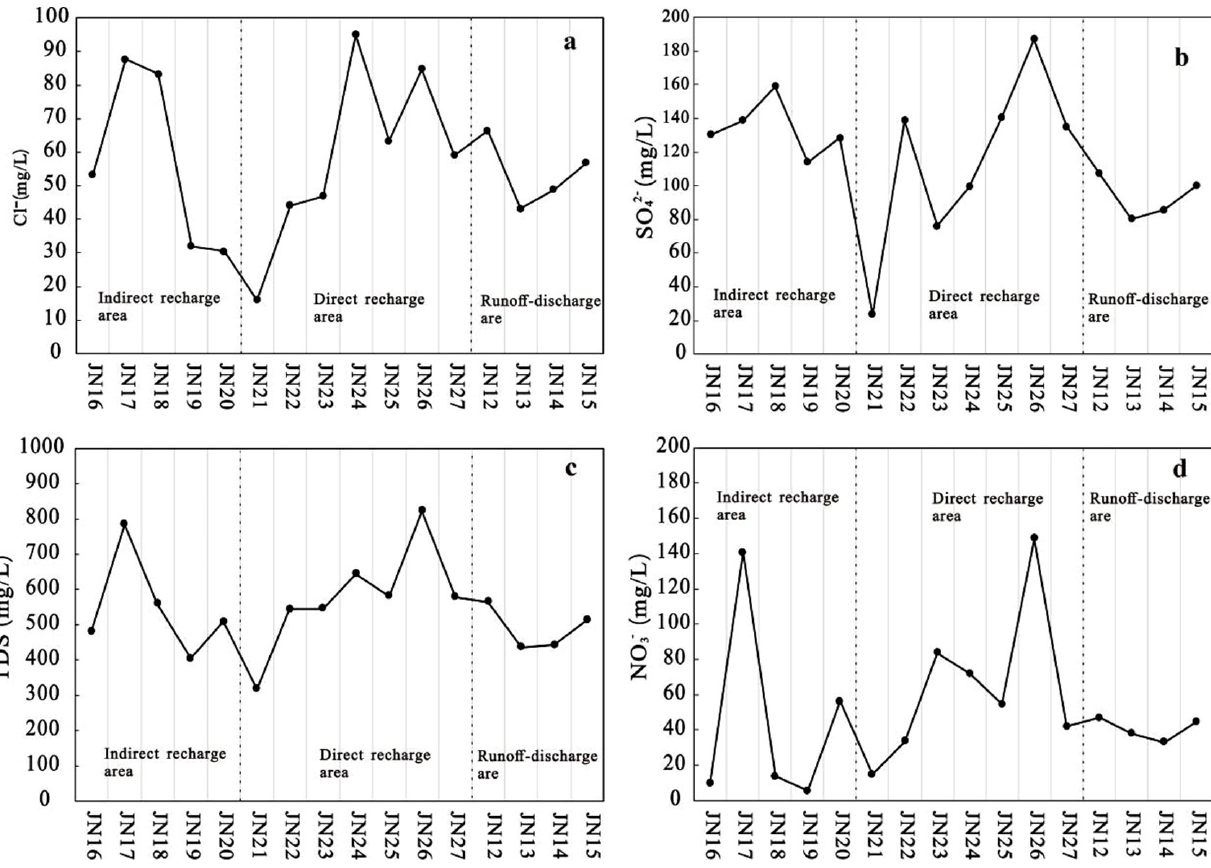
Figure 8. Variation of ion components (( a ) Cl − ; ( b ) SO 4 2 − ; ( c ) TDS; ( d ) NO 3 − ) in karst water along Flow Path II (west → north).